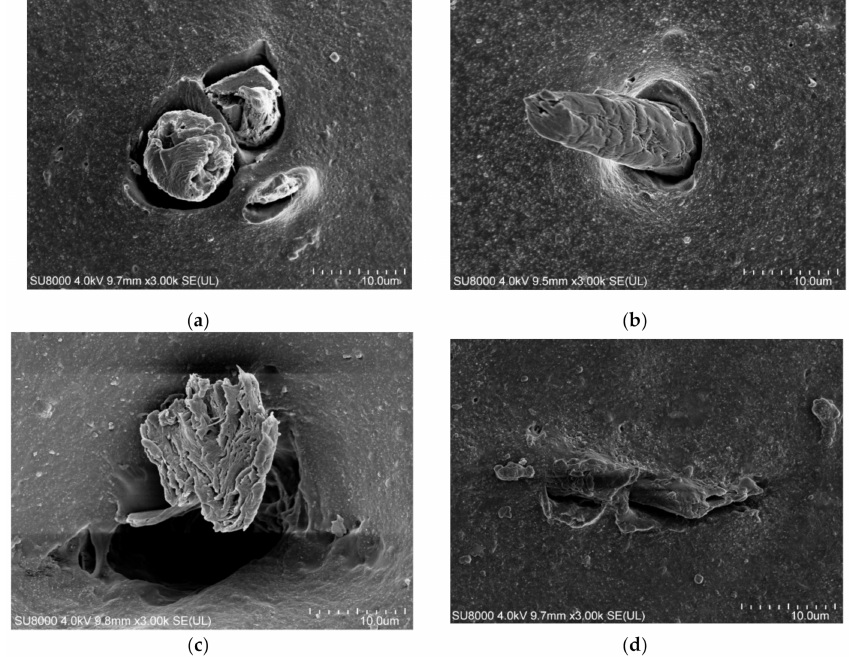
Figure 9. SEM of areca fiber / natural latex modified with silane coupling agent: ( a ) Untreated; ( b ) Si − 69; ( c ) KH − 550 and ( d ) KH −